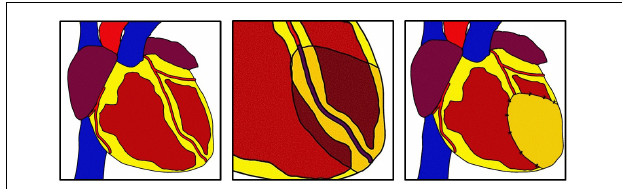
FIGURE 1 | Epicardial infarct repair. After myocardial infarction a bioinductive patch is sewn using simple interrupted sutures over the infarcted area. The patch modulates epicardial and myocardial cells to promote angiogenesis and antifibrosis through direct contact or elution of growth factors. This technique can be used in concomitance with